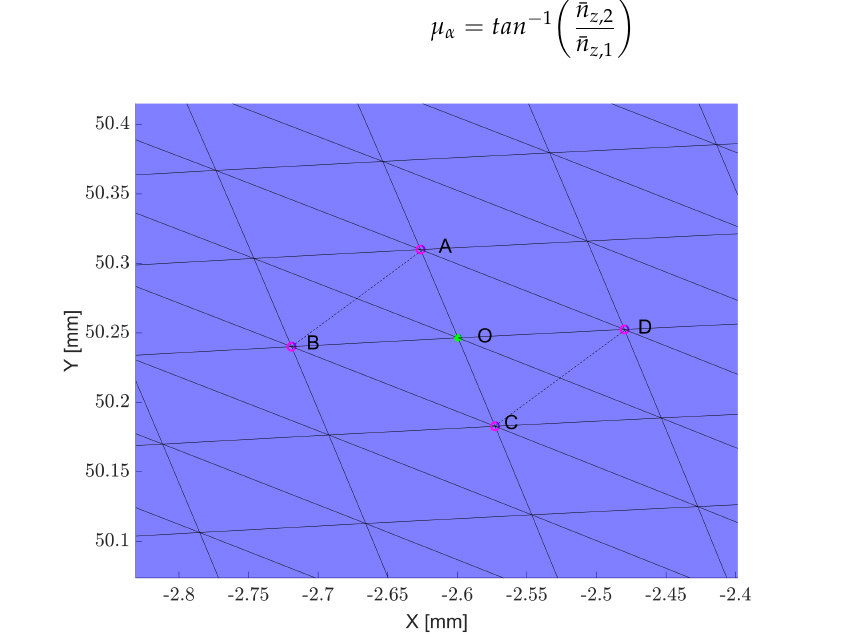
Figure 4. Points considered for the calculation of the normal vector to the contact